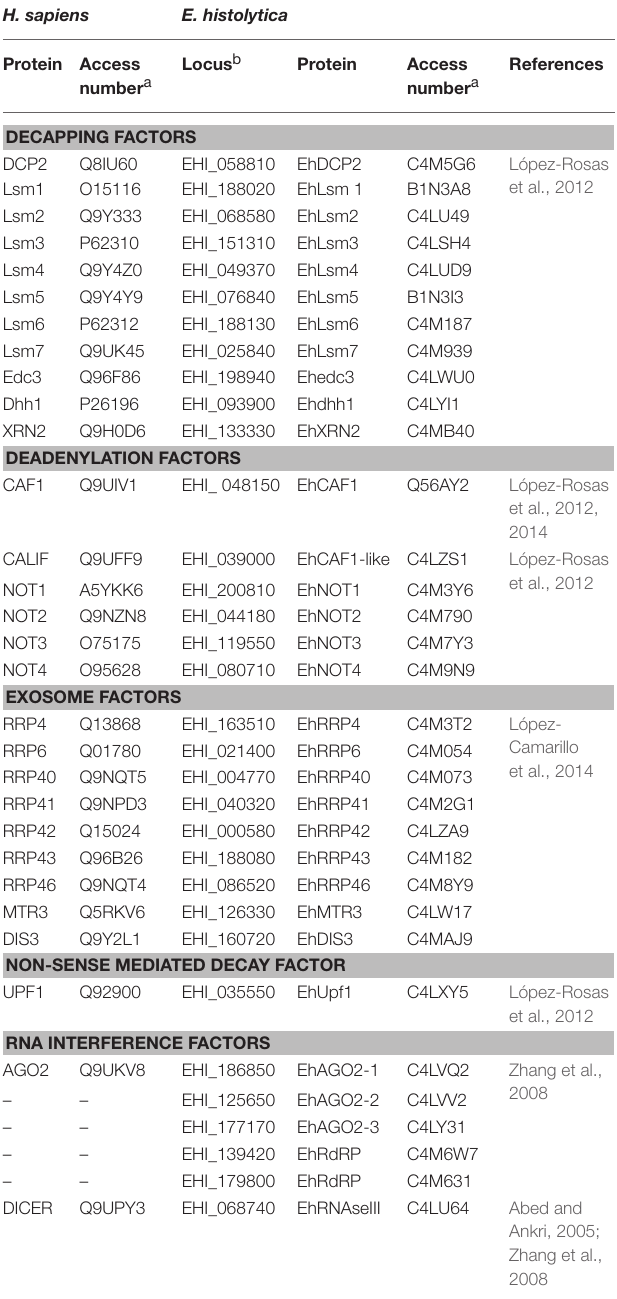
TABLE 3 | Comparison of mRNA decay machineries between human and E. histolytica . H.